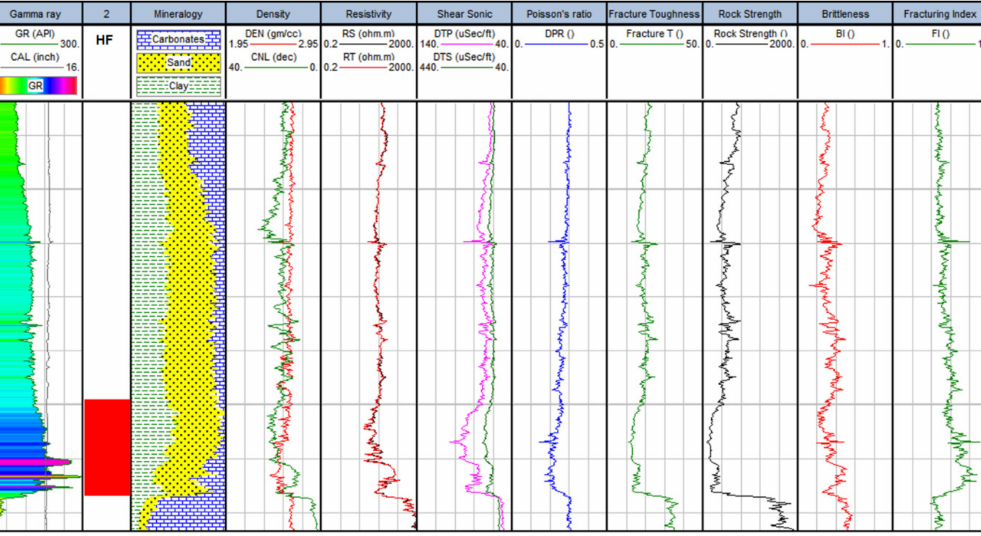
Figure 9. Logging curve of a horizontal section of shale gas well. The red box in column 2 indicates the hydraulic fracturing